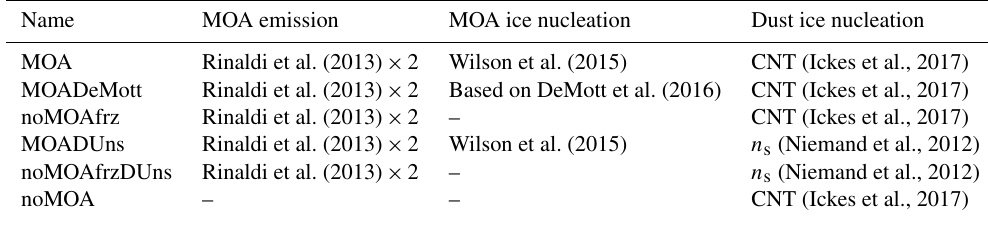
– Long et al. (2011); Sofiev et al. (2011) Table 3. List of 10-year free-running simulations. Fields marked with dashes (–) are not relevant for the set-up. “MOA” refers to the control free-running simulation where the Rinaldi et al. (2013) MOA emission is scaled up by two times; “MOADeMott” refers to a simulation where immersion freezing by MOA is replaced by the fit to the DeMott et al. (2016) data for total sea spray; “noMOAfrz” refers to a simulation where MOA is emitted but not acting as INP; “MOADUns” is the same as “MOA” but with the dust freezing parameterisation replaced by the n s scheme following Niemand et al. (2012); “noMOAfrzDUns” is the same as “noMOAfrz” except with a different dust freezing parameterisation; and lastly, “noMOA” is a free-running simulation where MOA is not emitted. CNT indicates classical nucleation theory.